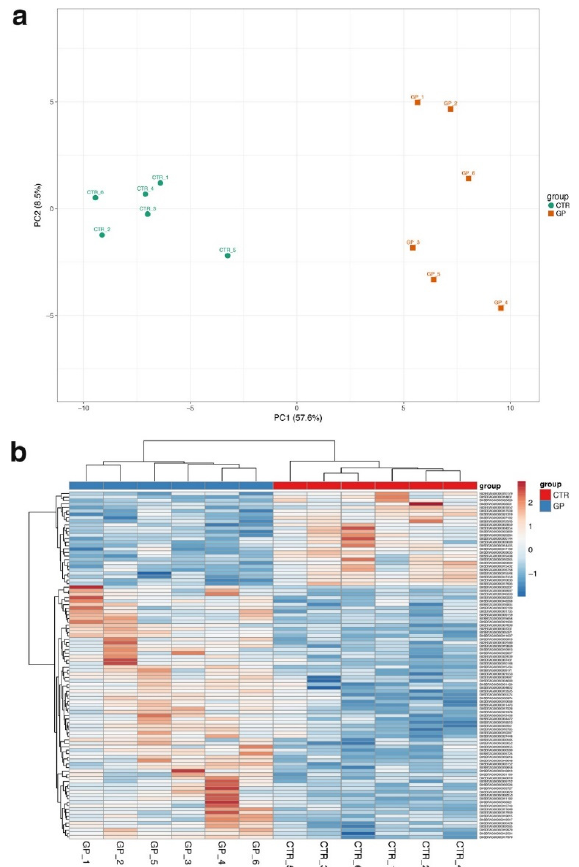
Figure 1. Principal Component Analysis (PCA) and hierarchical clustering heatmap. PCA and heatmap of the top 100 deregulated genes in dairy cows fed for 60 days with a GP-supplemented diet (GP T60 vs. CTR T60). ( a ) PCA plot of the GP (orange squares, right side) and CTR individuals (green circles, left side) after 60 days of GP dietary supplementation. ( b ) Heatmap generated from the DEGs using the hierarchical clustering (Euclidean distance clustering algorithm) of the top 100 deregulated genes of the GP group.